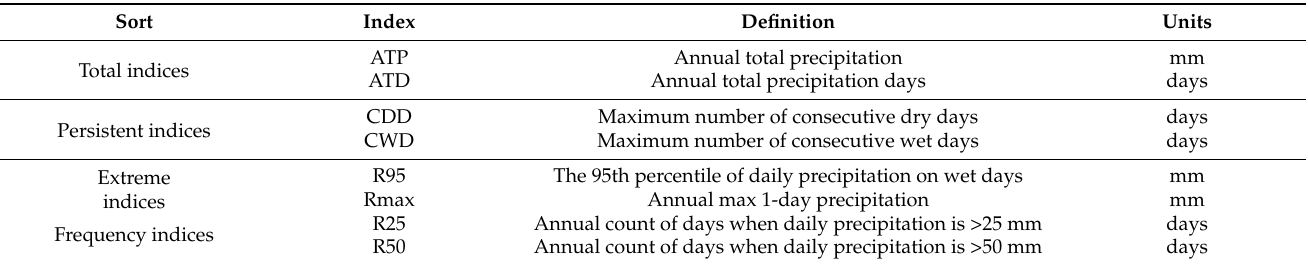
Table 1. Detailed information on precipitation